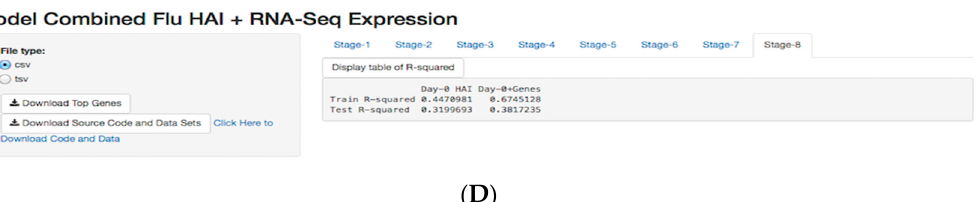
Figure 7. R Shiny App for modeling of flu vaccine HAI response. Sidebar panel displays the settings and main panel displays the result of modeling. ( A ) Sidebar panel displays options specifying the training and testing datasets. ( B ) Sidebar panel displays customization of the number of clusters, ( C ) selection of the regression modeling method, and ( D ) the number of genes filtered, including a download button for top 200 genes, where users are able to select the train and test data sets, The user can run the analysis for each tab and produce plots. Pre − loaded datasets are available by default in RData format. The web based app and source code are available at https://github.com/insilico/predictHAI and http:// insilico.utulsa.edu/predictHAI.